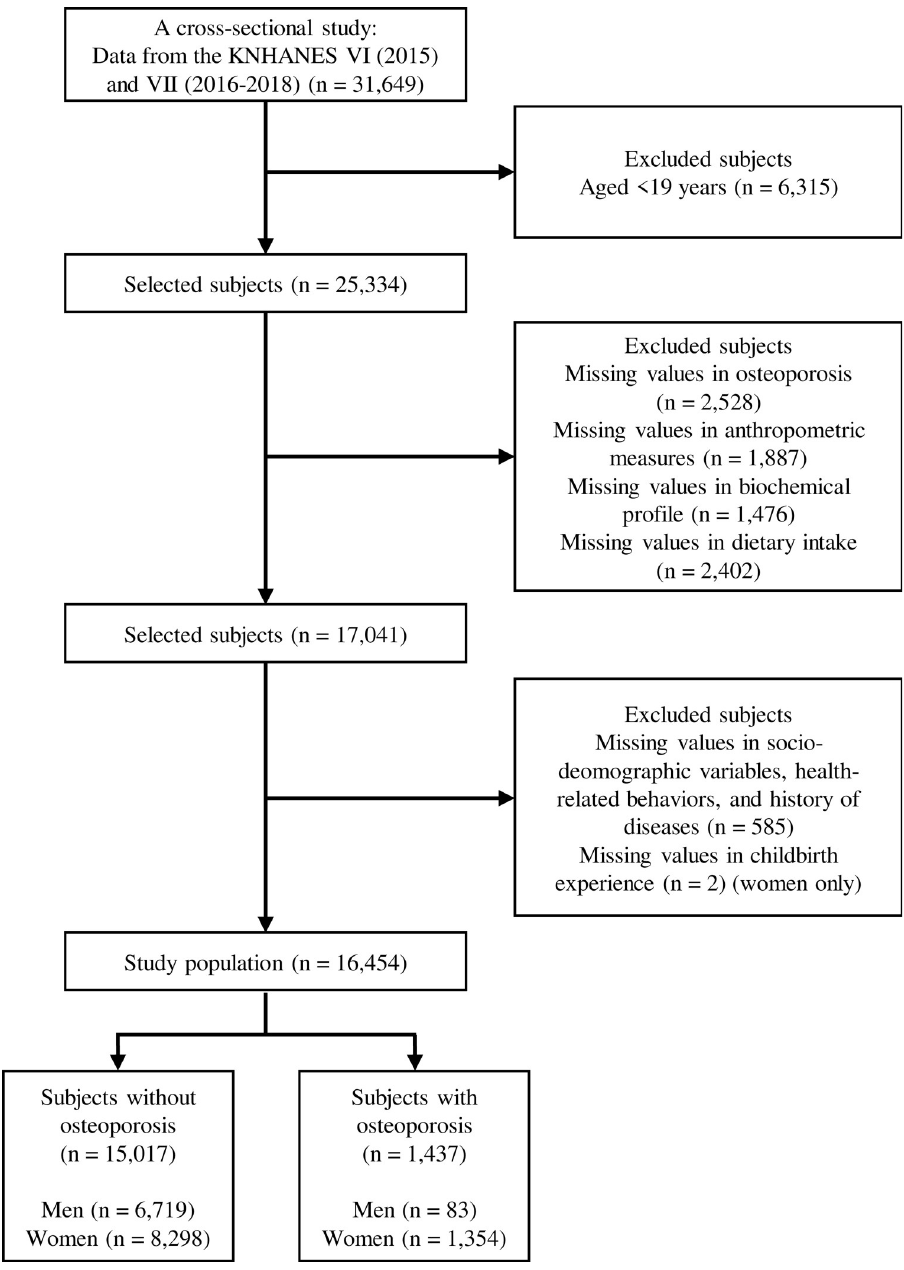
Fig 1. Sample selection procedure used in this